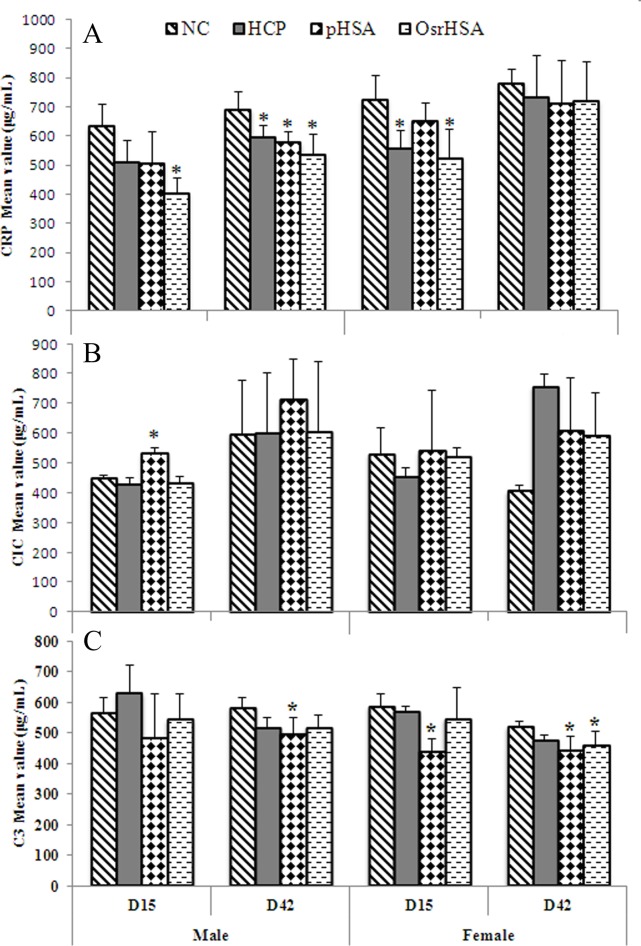
The changes in CRP, CIC and C3 levels at D15 and D42.Panel A is CRP, panel B is CIC, and panel C is C3. Data are presented as the mean ± SD (n = 5); "*" Indicates a statistically significant difference according to ANOVA and Dunnett’s test (P≤0.05).